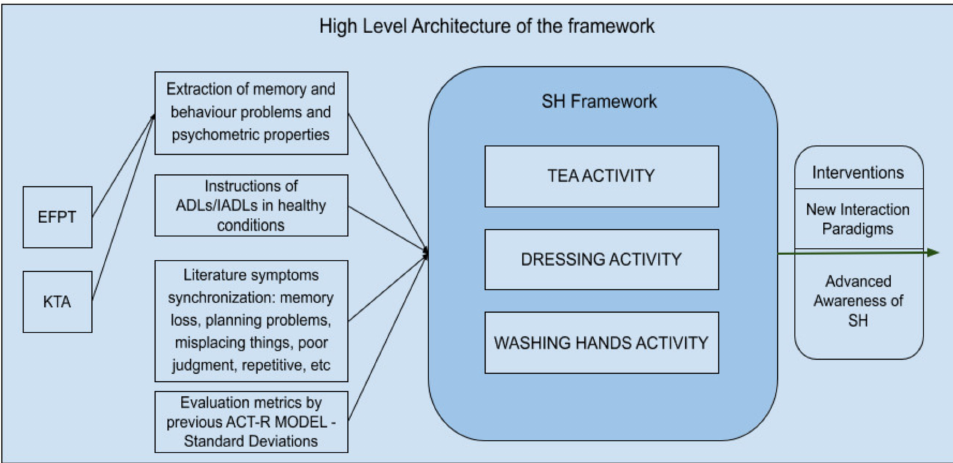
Figure 1. High-level architecture of the framework and the methodology